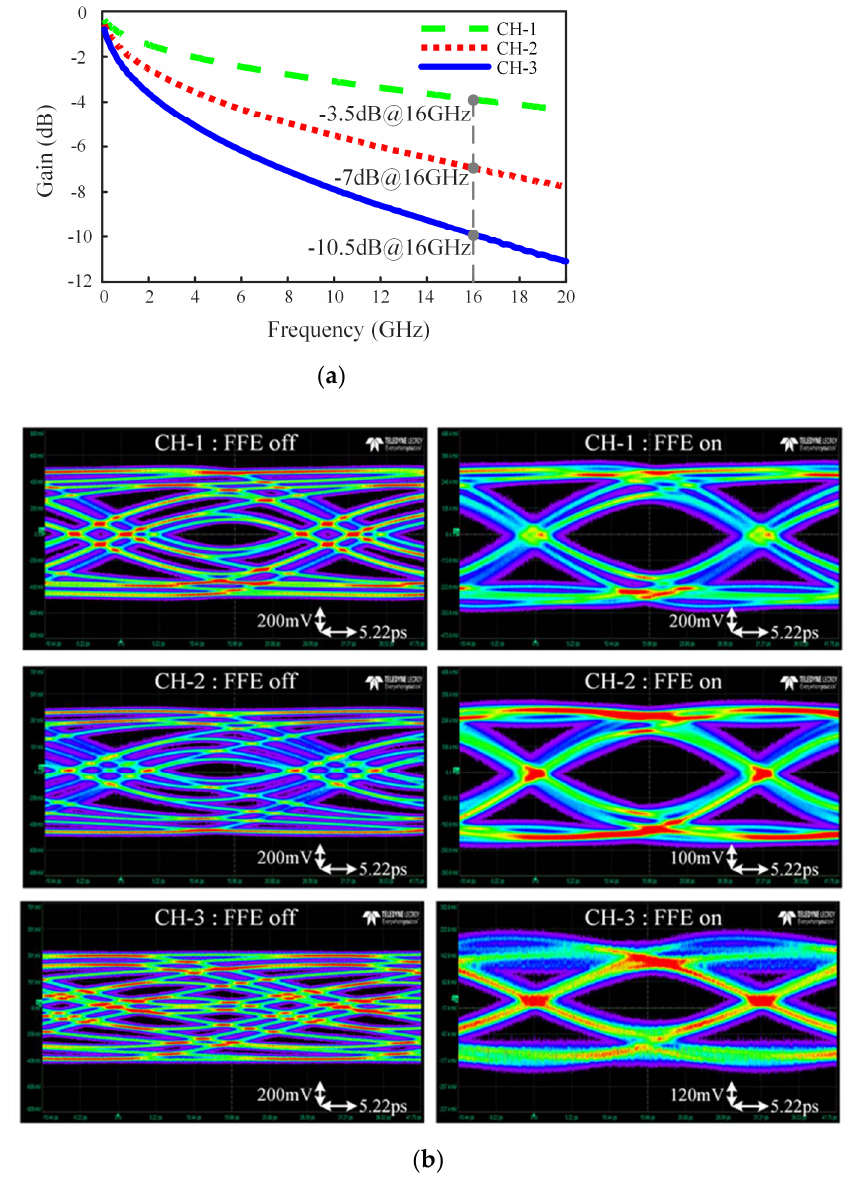
Figure 11. ( a ) The frequency response of the three different channels and ( b ) measured output eye diagrams of the proposed TX lane-0 at 32 Gb/s with different FEEs off and